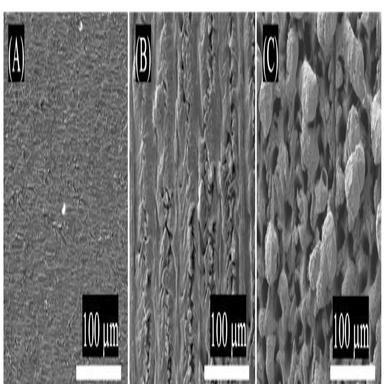
SEM images of A: S1 (control samples), B: S2 (single laser treated) and C: S3 (double-laser treated).